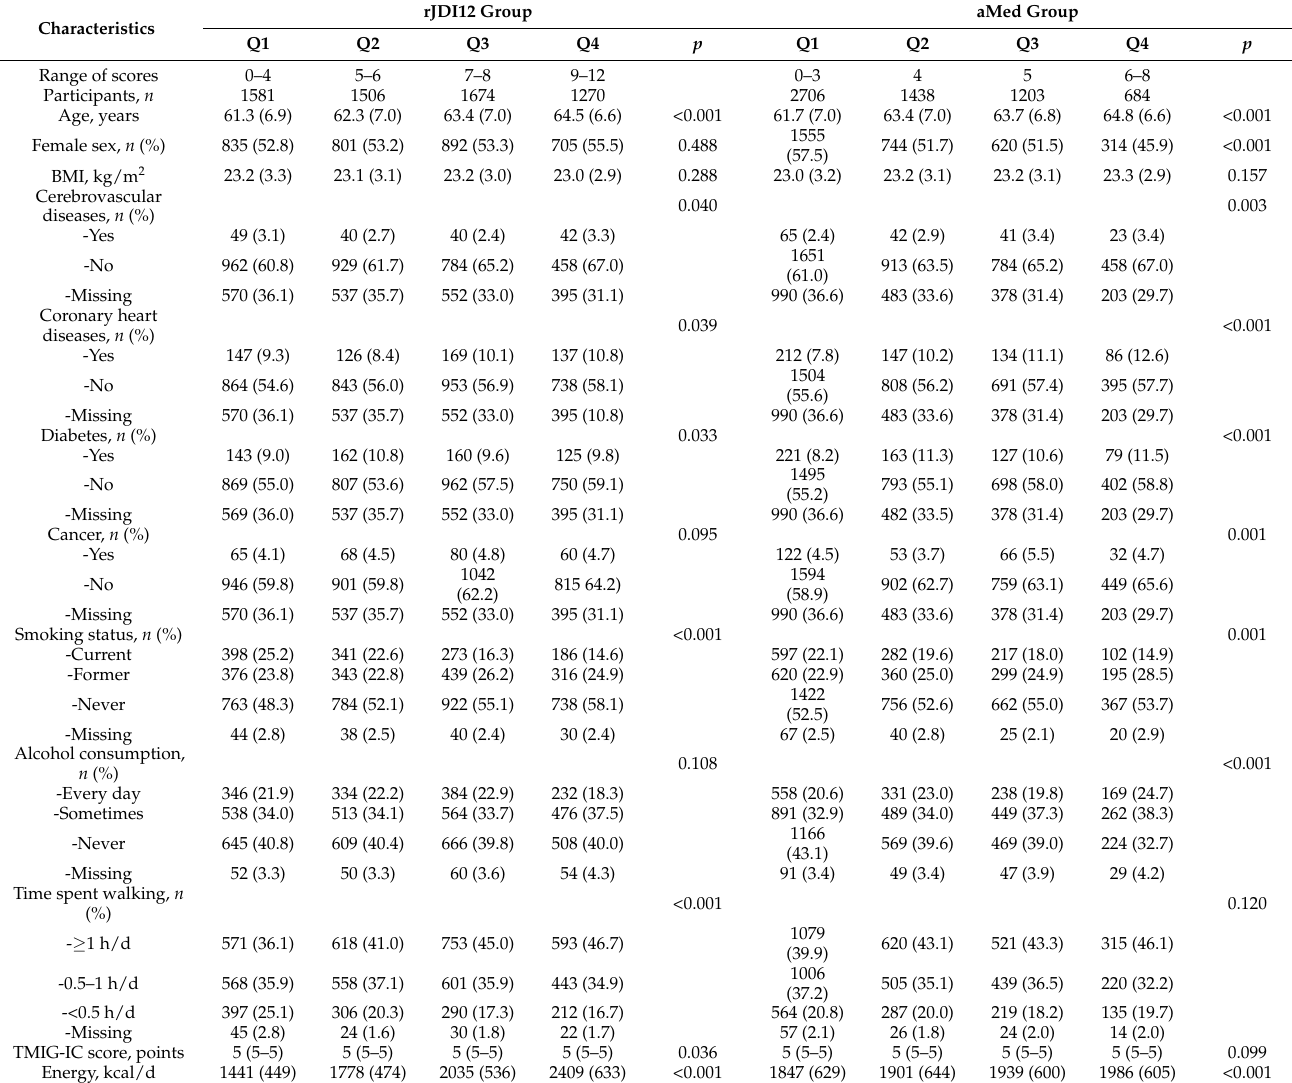
Table 1. Characteristics of the participants across the two dietary patterns ( n =